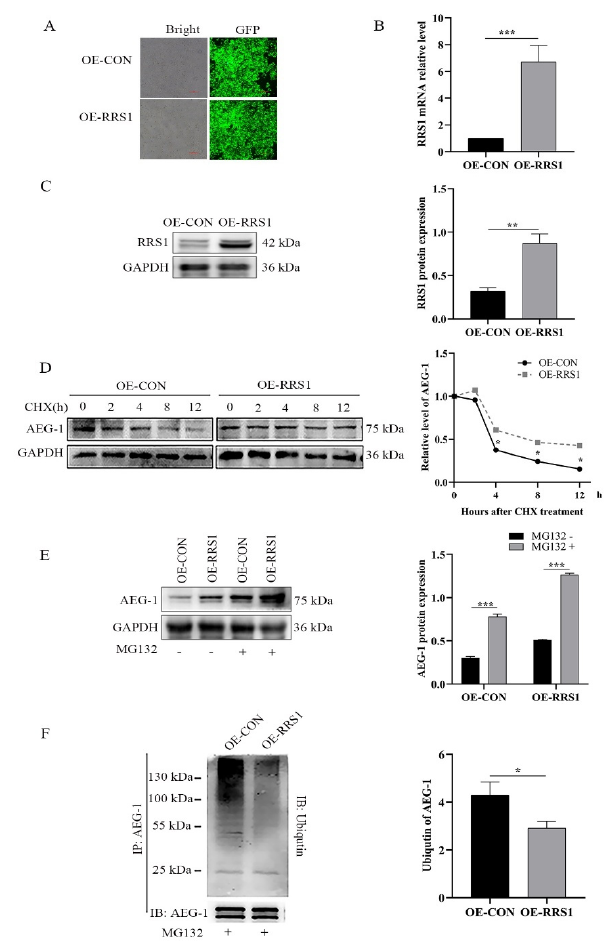
Figure 4. RRS1 blocked AEG-1 ubiquitination and proteasomal degradation. ( A ) A stable transgenic strain with RRS1 highly expressed was constructed. MCF-7/DDP cells were infected with lentivirus, and the fluorescence transfection efficiency was detected after 72 h, with scale = 100 µ m. After 72 h of infection, the cells were screened with puromycin of 1 µ g/mL for 1 week. ( B ) RRS1 mRNA levels in OE-CON and OE-RRS1 MCF-7/DDP cells. ( C ) Immunoblot showing RRS1 protein levels in the OE-CON and OE-RRS1 MCF-7/DDP cells. ( D ) The half-life of AEG-1 protein in cells treated with CHX (710 µ M). ( E ) AEG-1 protein levels in cells treated with MG132 (10 µ M) for 12 h. ( F ) Cells were treated with MG132 (10 µ M) for 12 h; the cell lysates were subjected to immunoprecipitation with anti-AEG-1 antibodies, followed by western blotting with anti-ubiqutin antibodies. Data are expressed as means ± SDs of at least three independent experiments. * p < 0.05, ** p < 0.01, *** p < 0.001. RRS1, human regulator of ribosome synthesis 1; AEG-1, astrocyte elevated gene- 1; CHX, cyclo- heximide.